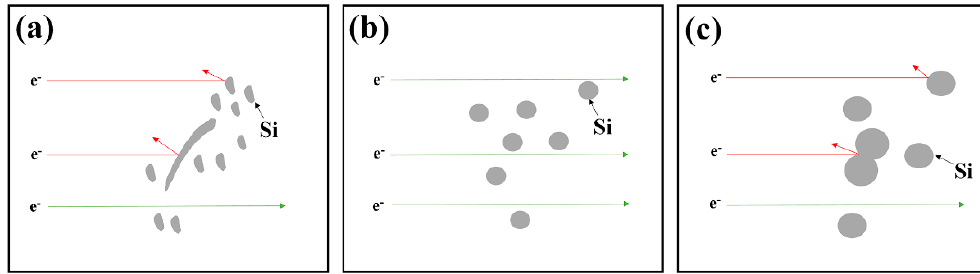
Figure 7. Schematic diagram of electron transmission in different states: ( a ) as-cast ( b ) ST6 ( c ) LT6.